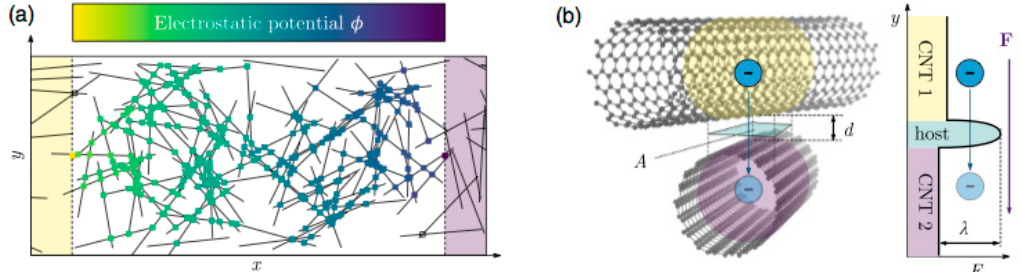
Figure 1. Sketch of electrical conduction in randomly dispersed carbon nanotubes (CNTs) in doped resins. ( a ) Randomly oriented CNT. ( b ) Contact resistance among nanotubes (from reference [6], with CC permission). with CC